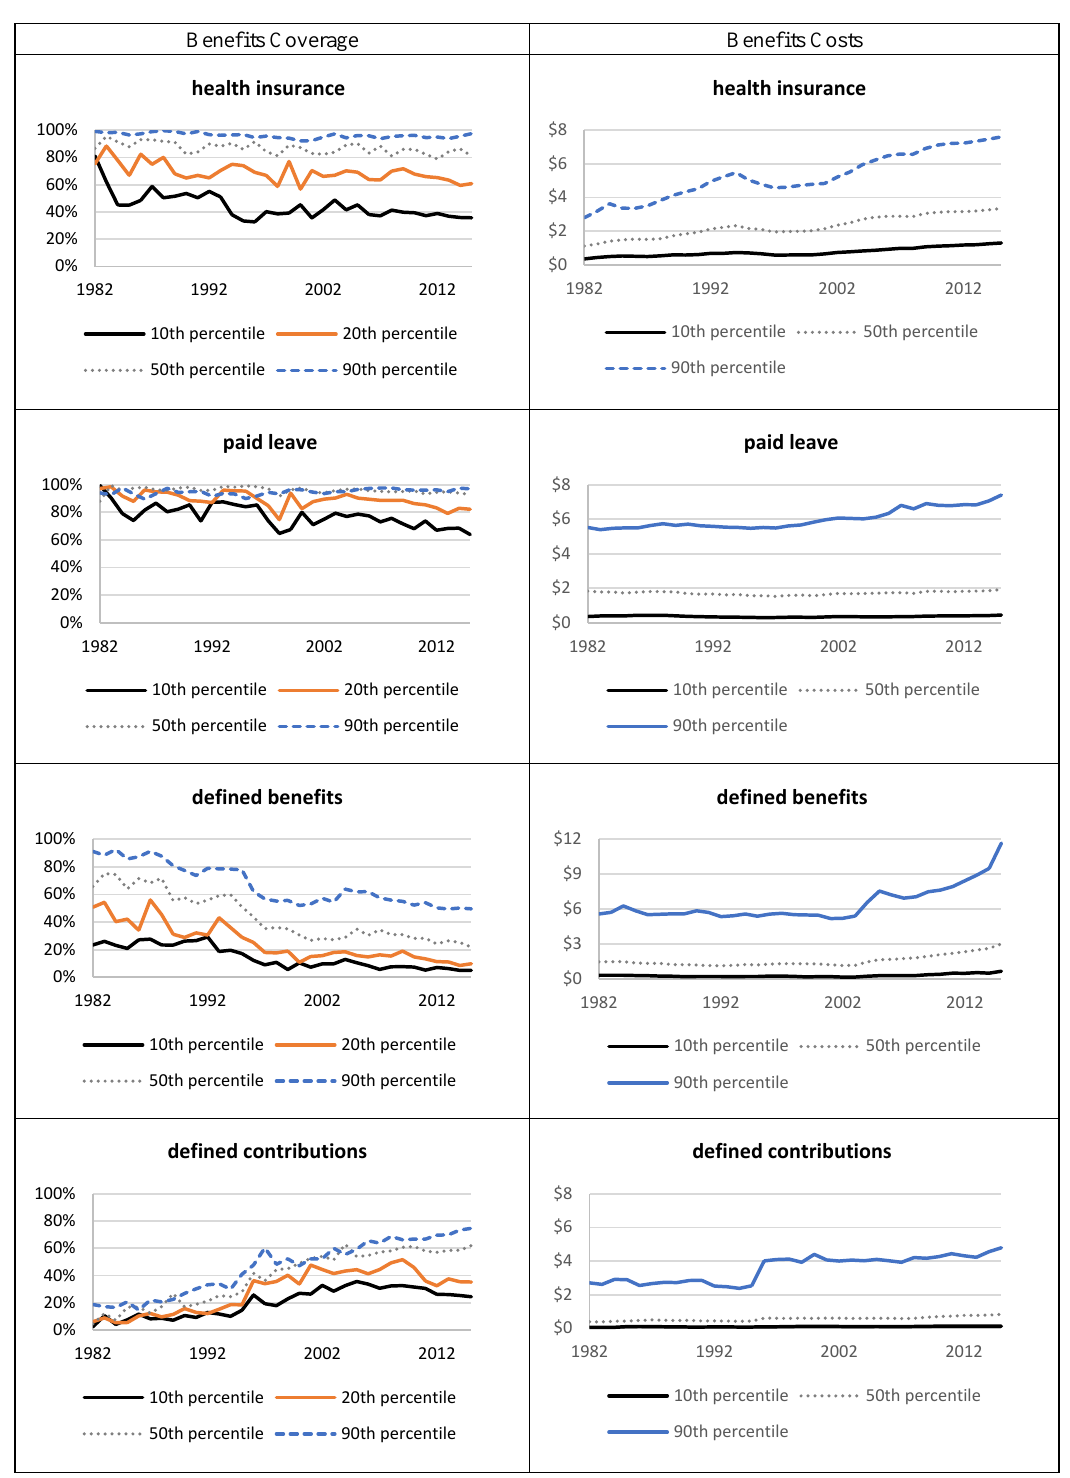
percentiles and benefits costs (for covered workers).